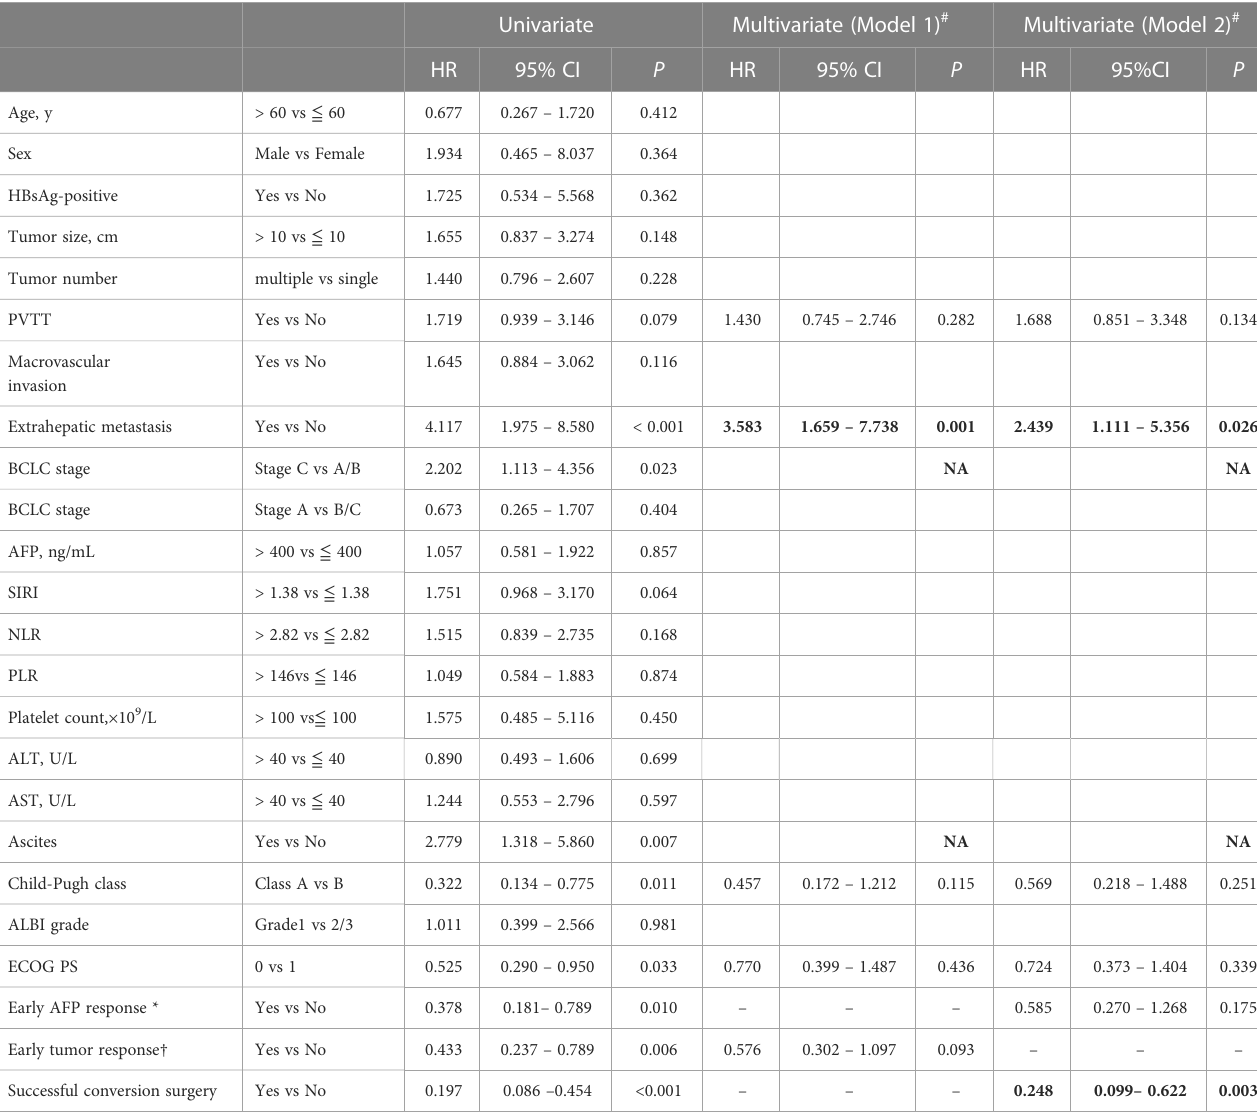
TABLE 4 Factors associated with progression-free survival in 94 patients who received conversion therapy for initially unresectable